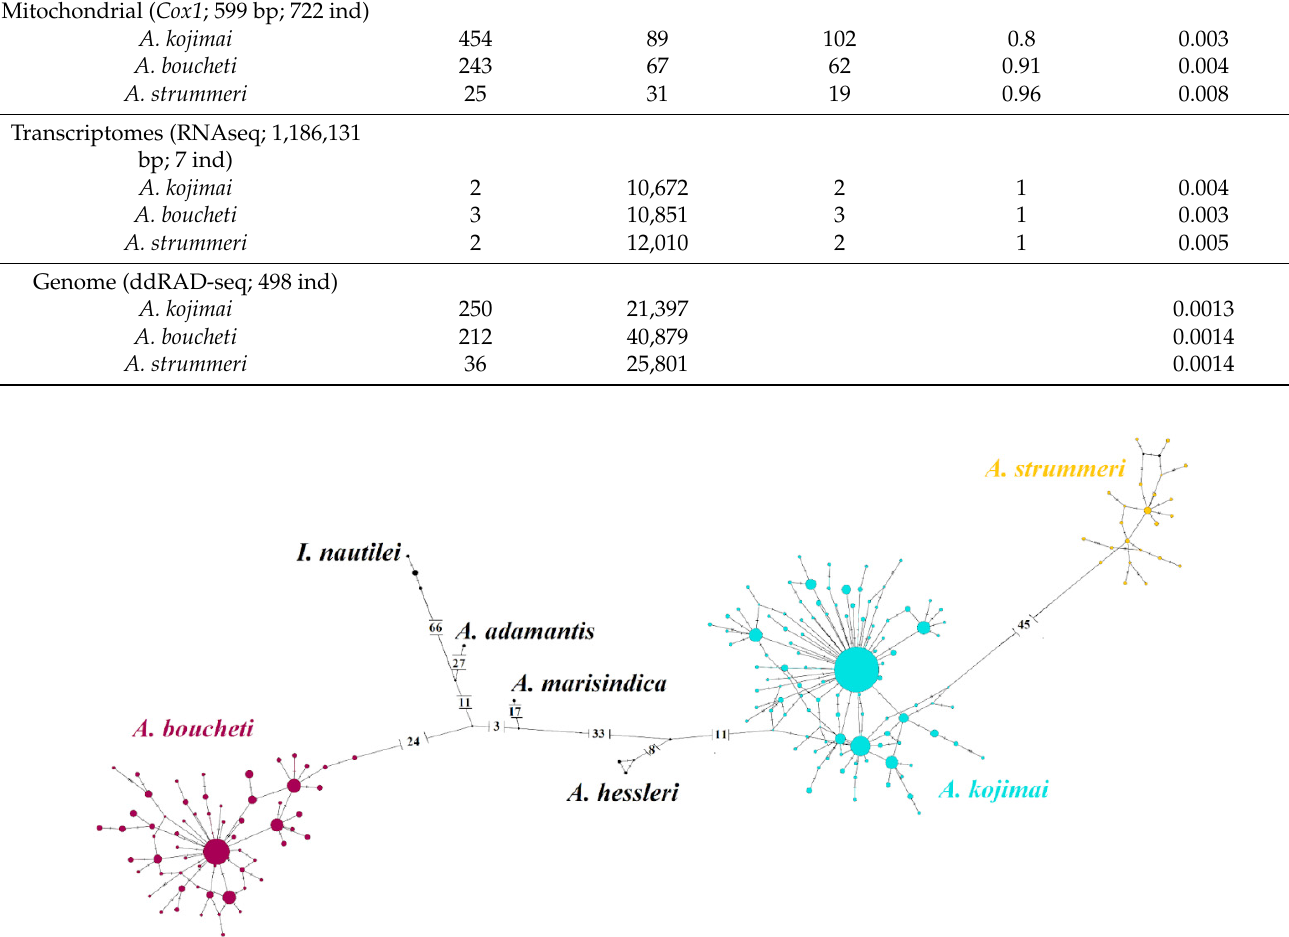
Table 2. Inter-specific genetic divergence and differentiation for the three genetic datasets: Cox1 Table 1. Intra-specific genetic diversity of the three species for the three genomic datasets: Cox1 mito- chondrial gene, ddRAD-seq nuclear SNPs, and RNA-seq nuclear SNPs. N : sample size; K : number of polymorphic sites; H : number of haplotypes; Hd : haplotype diversity, and π : nucleotide diversity. N